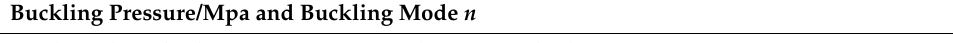
Figure 8. Buckling mode of the composite cylindrical shell. Table 6. Analytical, FEM and experimental Table 5. Comparison of the critical buckling pressures.